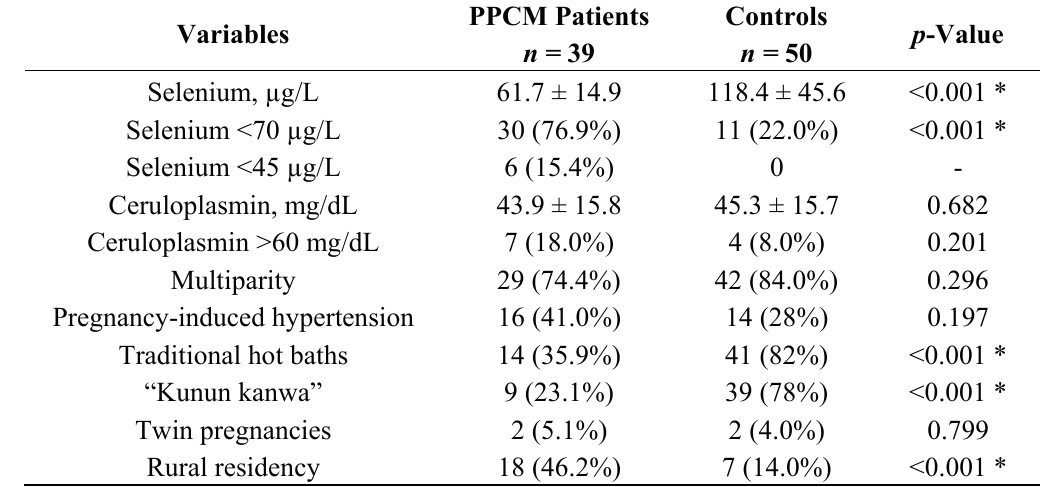
Table 2. Profile of risk factors for peripartum cardiomyopathy among PPCM patients and